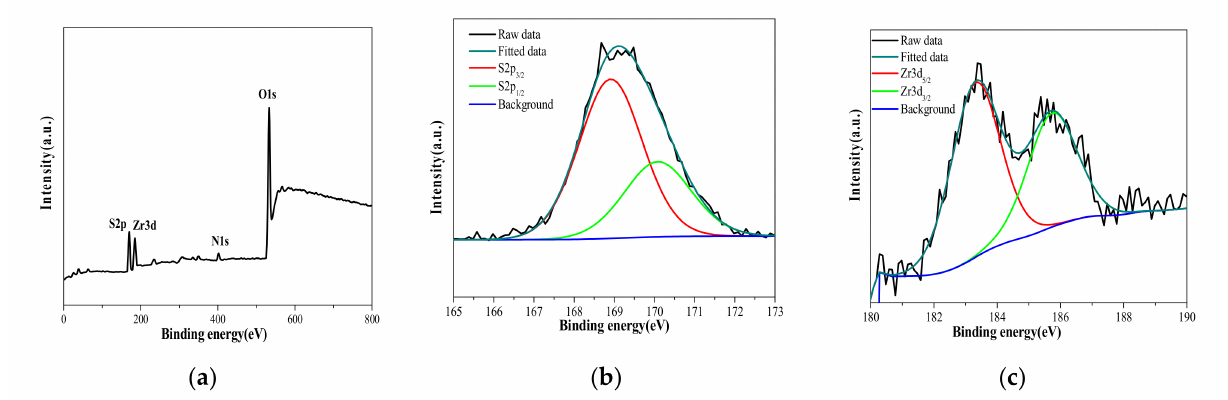
Figure 3. ( a ) XPS survey spectra of SO 4 ZrO 2 , ( b ) S2p spectra, and ( c ) Zr3d spectra of the synthesized SO 4 ZrO 2